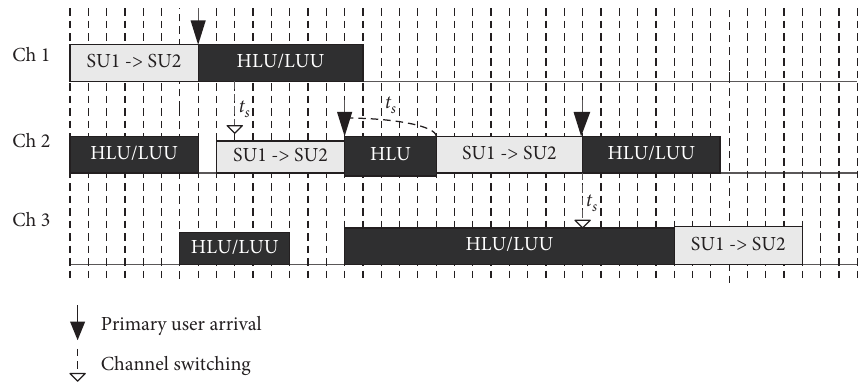
Figure 10: Example scenario of transmission process with channel